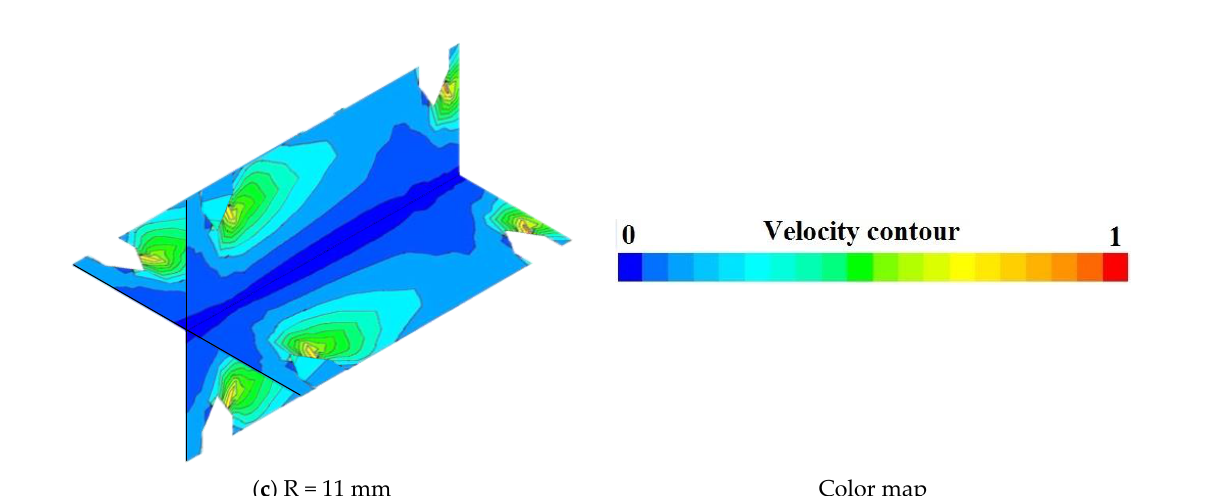
Figure 15. Velocity magnitude contours for various configurations of Case B with different R parameters at B 2 = 24 mm, Re = 15,000, and 𝜑 = 0.5%.